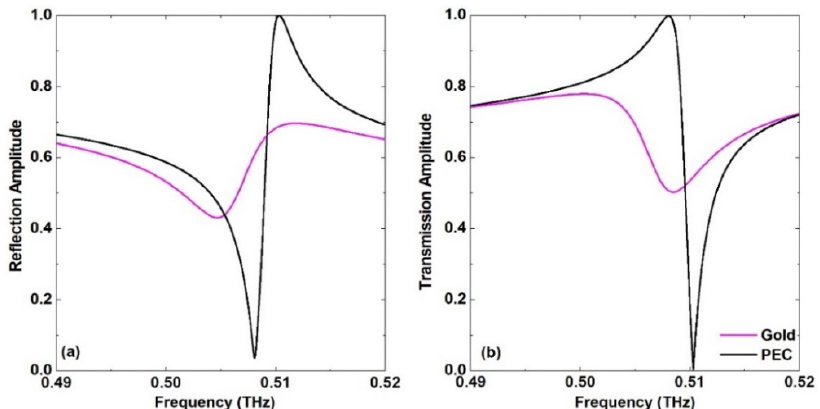
Figure 6. ( a ) Reflection and ( b ) transmission spectra of the symmetric CSRRs at an incidence angle of 30 o for both gold and PEC metallic layers.